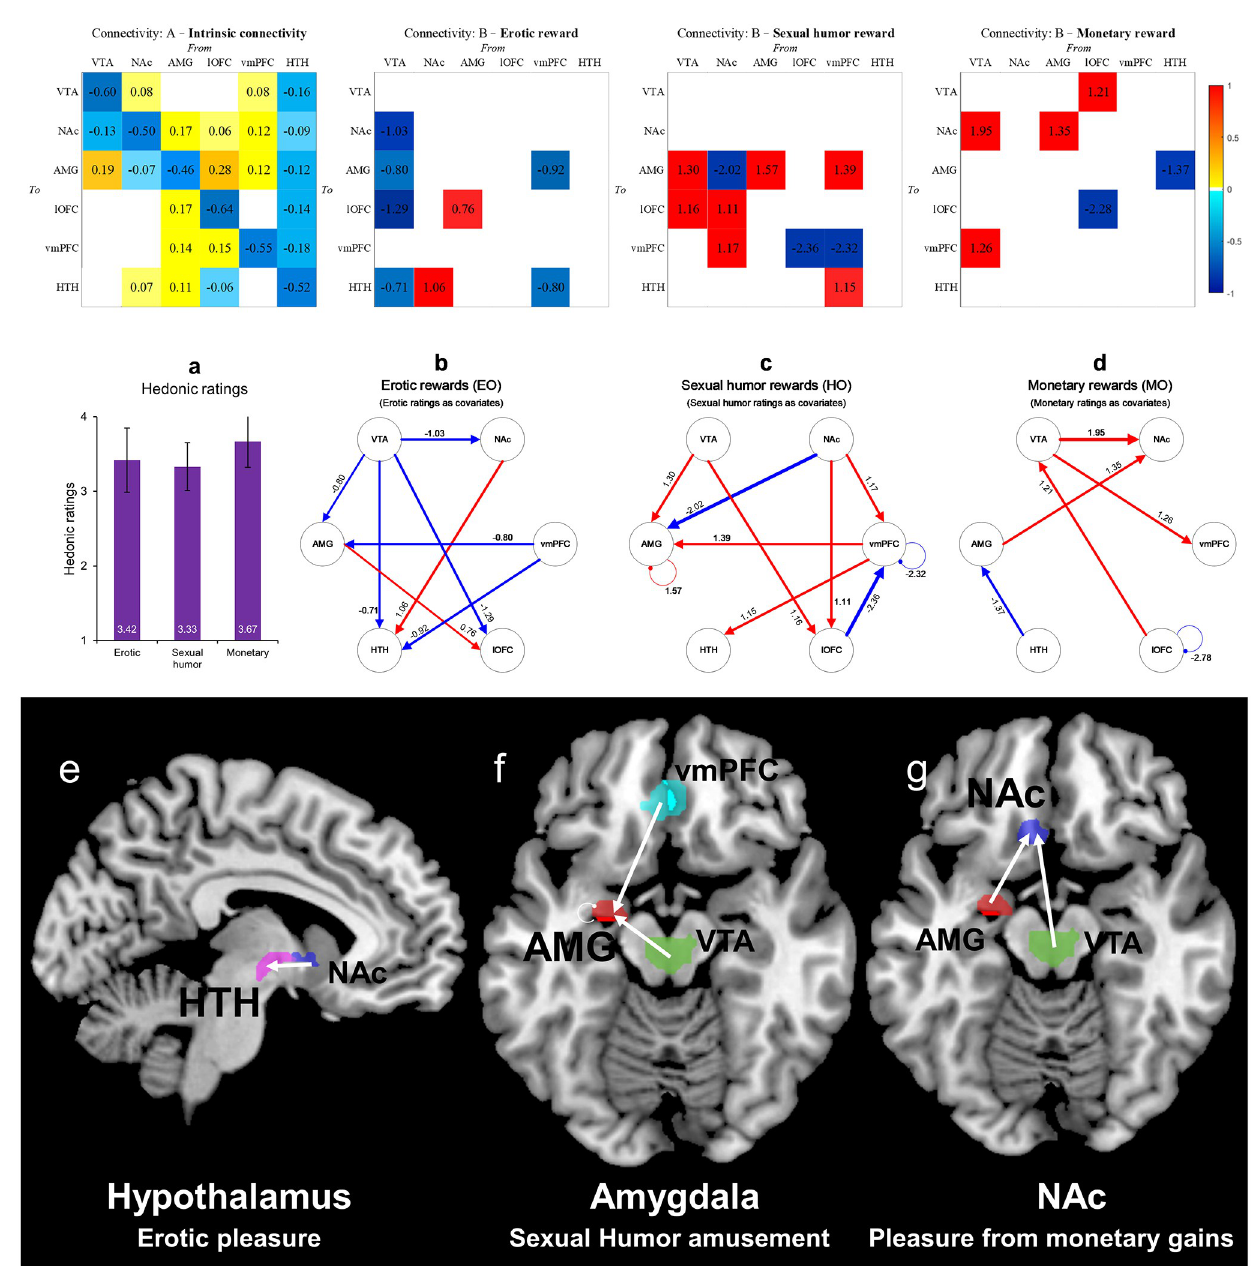
Fig 1. Effective connectivity in processing the consumption of erotic, sexual humor, and monetary rewards with hedonic ratings as covariates during the outcome phase. (Upper) Results of the DCM analysis are presented as connection weights given by the time constants in Hz for intrinsic connections (A matrix) and bilinear moderators (B matrix) for which significant effects (at 99% confidence). (Middle) The red lines represent positive modulatory effects and blue lines represent negative modulatory effects. Self-connections are displayed in the figure. (a) Hedonic ratings of erotic, sexual humor and monetary rewards from in-scan behavioral ratings on a 4-point Likert scale. Error bars represent the standard deviation (SD) of the mean. (b) Modulatory effect of pleasure from erotic images with ratings as covariates. (c) Modulatory effect of amusement from sexual humor with ratings as covariates. (d) Modulatory effect of pleasure from monetary rewards with ratings as covariates. (Lower) The hedonic ratings from in-scan data as covariates for erotic, sexual humor, and monetary rewards are associated with the hypothalamus, amygdala, and NAc, respectively. (e) Erotic pleasure was associated with a connection from the NAc to the hypothalamus. (f) The experience of amusement from sexual humor was associated with a connection from the VTA to the amygdala and from the vmPFC to the amygdala. (g) The experience of pleasure from monetary gains was associated with connections from the VTA to the NAc and from the amygdala to the